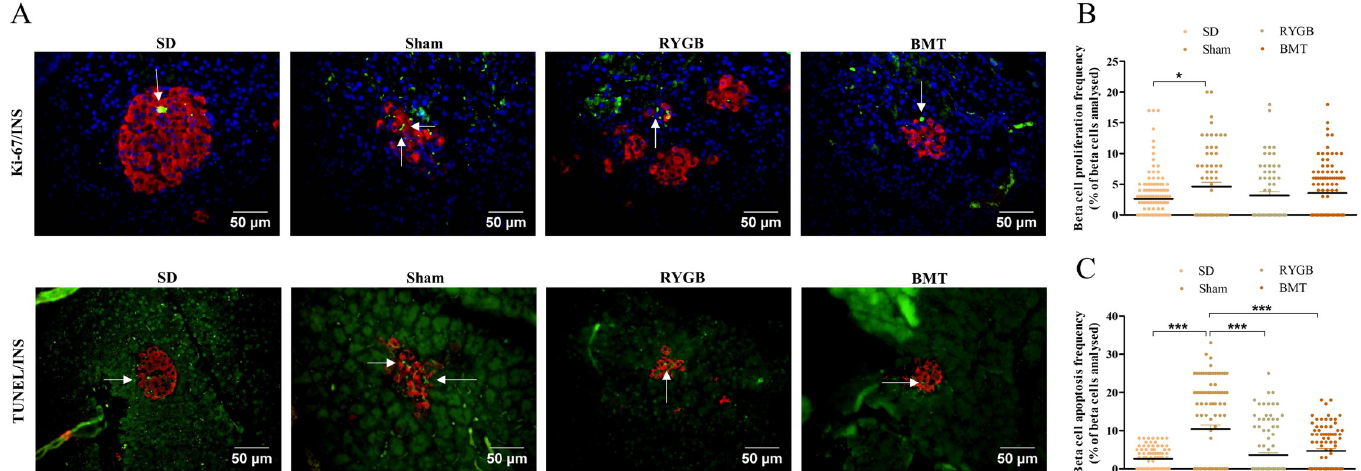
Fig 9. Effects of RYGB, BMT and sham surgery on beta- cell proliferation and apoptosis in ZDSD rats. (A) Representative images showing insulin (red) with Ki-67 TUNEL (green). Nuclei are demonstrated using DAPI staining (blue). (B) beta- cell proliferation frequency expressed as a percentage of beta- cells analyzed (C) beta- cell apoptosis frequency expressed as a percentage of beta- cells analyzed. Normal SD rats are included for comparison. Arrows indicate TUNEL and Ki-67 positive cells. Values are mean ± SEM (n = 4) with statistical significance evaluated using one-way ANOVA. � p < 0.05, ��� p < 0.001 compared to sham rats. Analyses carried out on 60–80 islets per